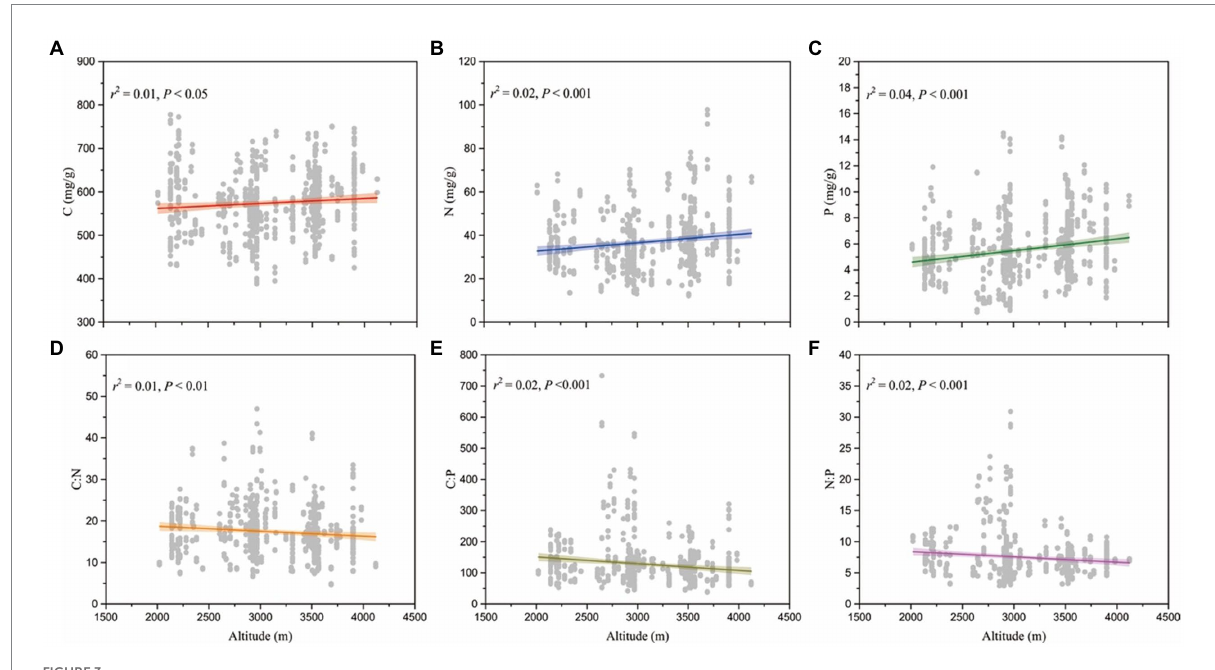
FIGURE 3 Changes in seed C, N, P (A-C) and C:N:P (D-F) ratios with the elevational